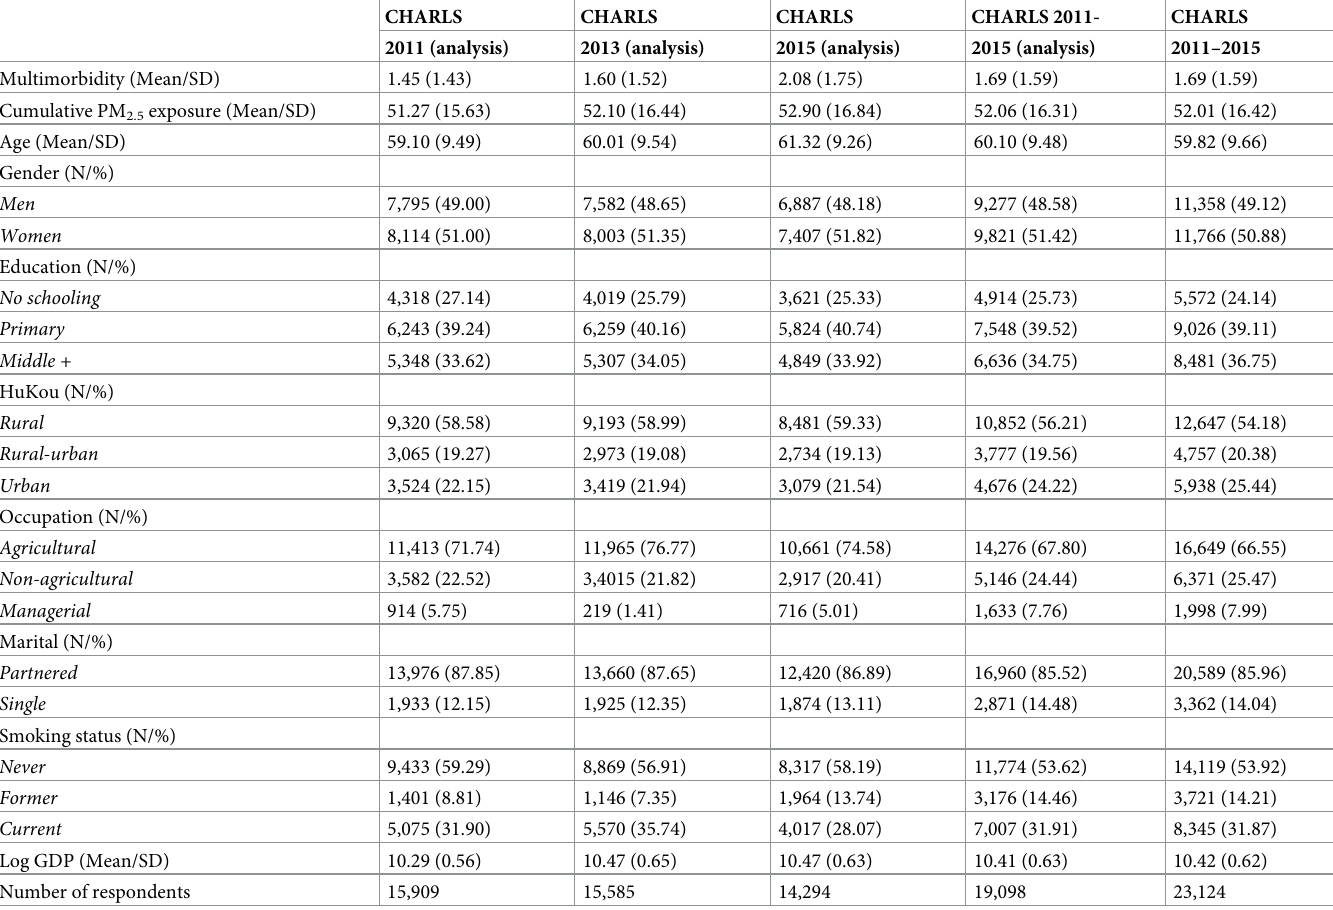
Table 1. Descriptive statistics of the study population in CHARLS 2011, 2013,